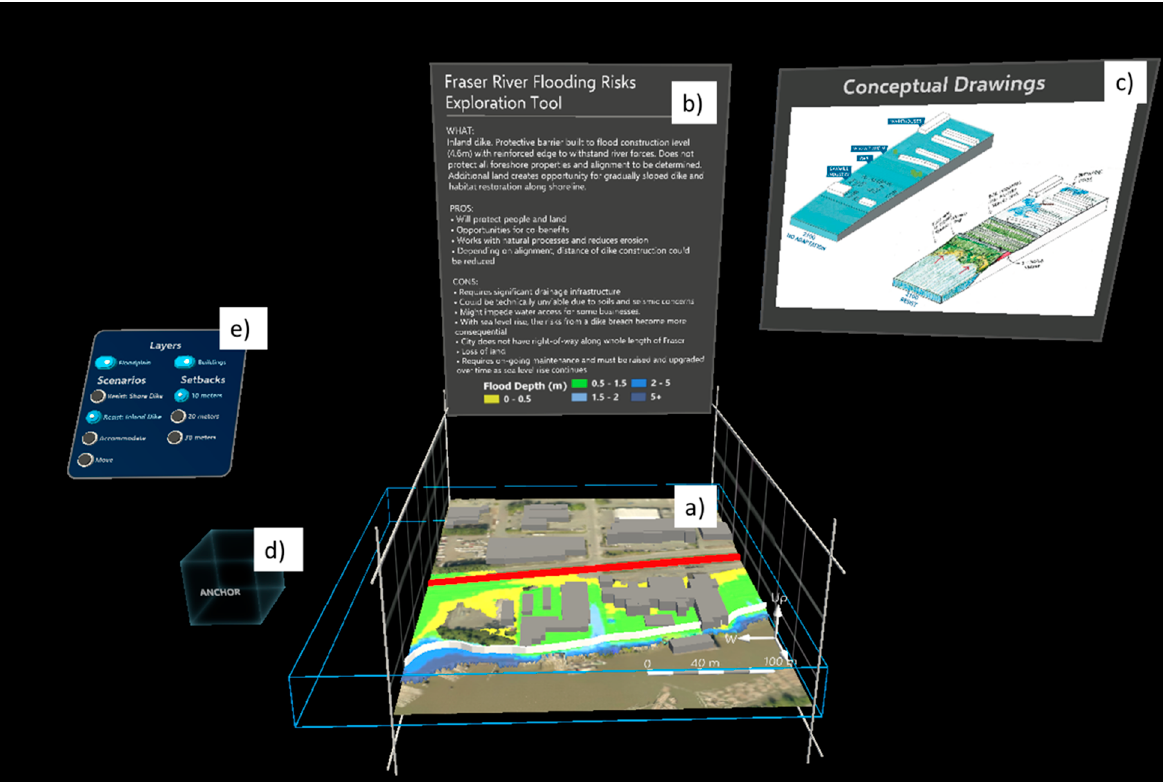
Figure 3. This screenshot captures the developed UI (user interface) of the visualization in a shared application, with an inland dike adaptation scenario selected: ( a ) 3D content, with 2 clipping planes, scale bar and directional arrows; ( b ) text panel providing vis. and scenario description; ( c ) conceptual drawings related to a scenario; ( d ) Anchor object used to synchronize position; ( e ) content menu.